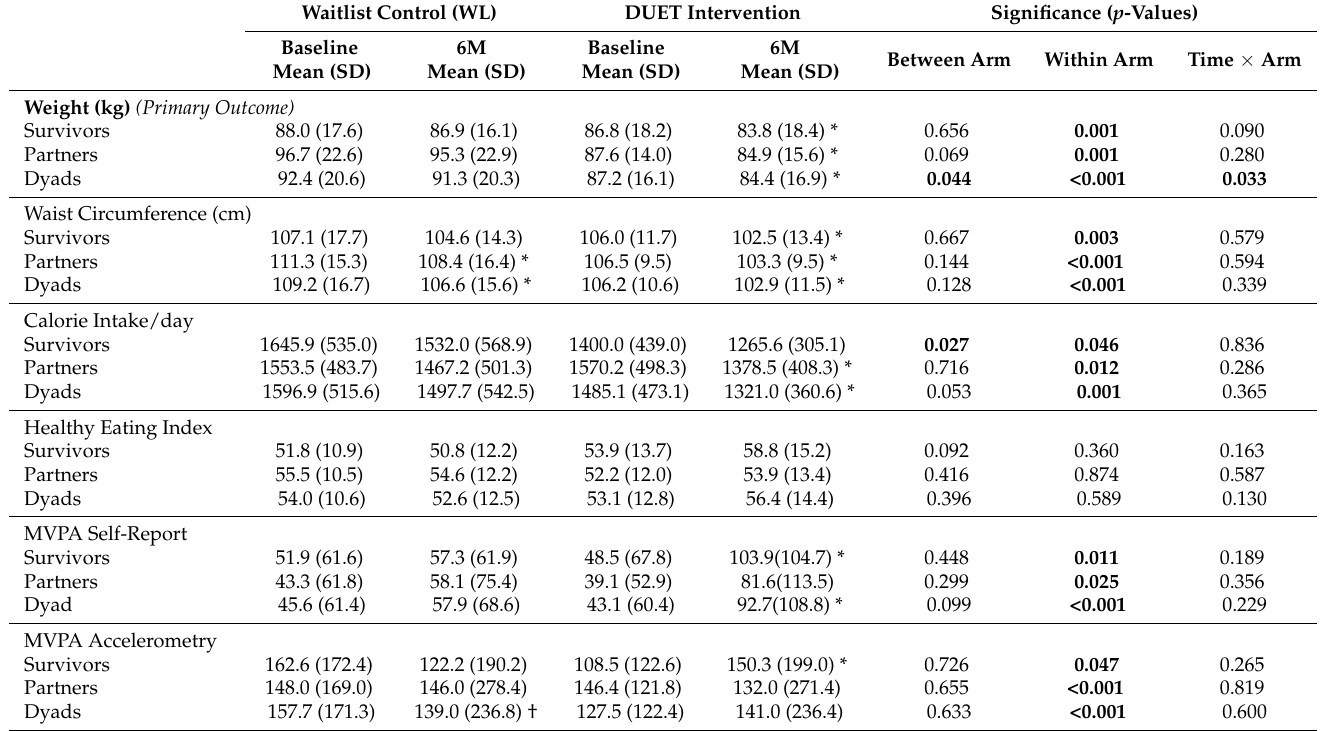
Table 2. Baseline to 6-m differences in adiposity, diet, and physical activity in waitlist vs. DUET intervention study